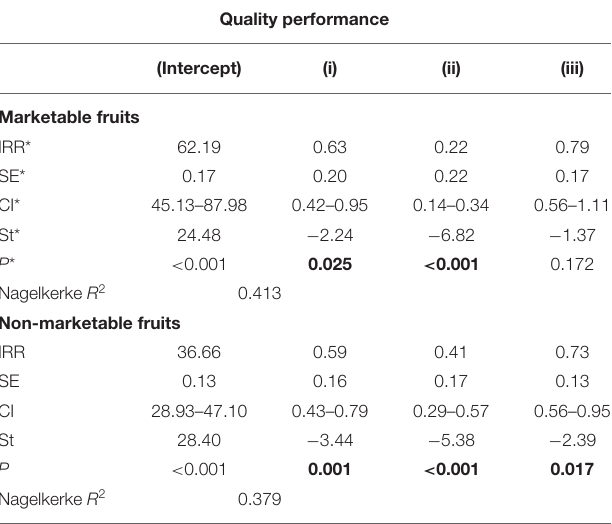
TABLE 4 | Factors influencing on quality performance via the number of marketable and non-marketable fruits for tomato plants.